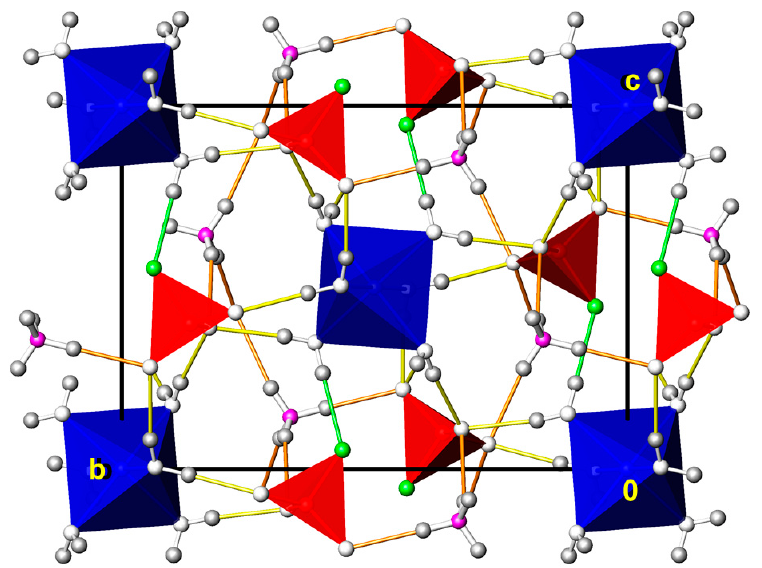
Figure 8. The crystal structure of (NH 4 ) 2 Ni(PO 3 F) 2 (H 2 O) 6 in a projection along [-100]. Colour code as in Figure 6; O–H···F hydrogen bonding is indicated by green lines.